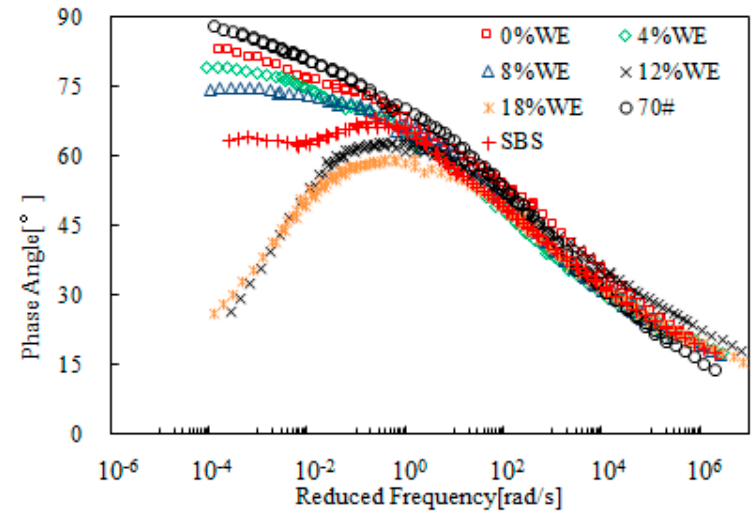
Figure 10. Master curves of the phase angle of WE-modified bitumen emulsion.